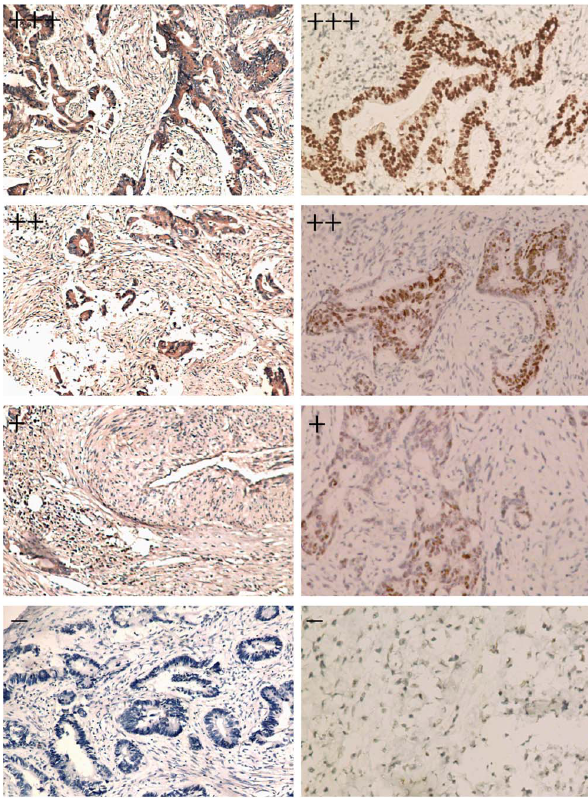
Figure 1. Representative Immunostains to Each Score of ABCC4 and p53 Protein in Pretreatment Biopsy Specimens. Left : The expression of ABCC4 protein was mainly cytomembrane and cytoplasm in epithelial rectal cancer cells ( 6 100 magnification); Right : The expression of p53 was mainly nuclei in the rectal cancer cells ( 6 100 magnification).